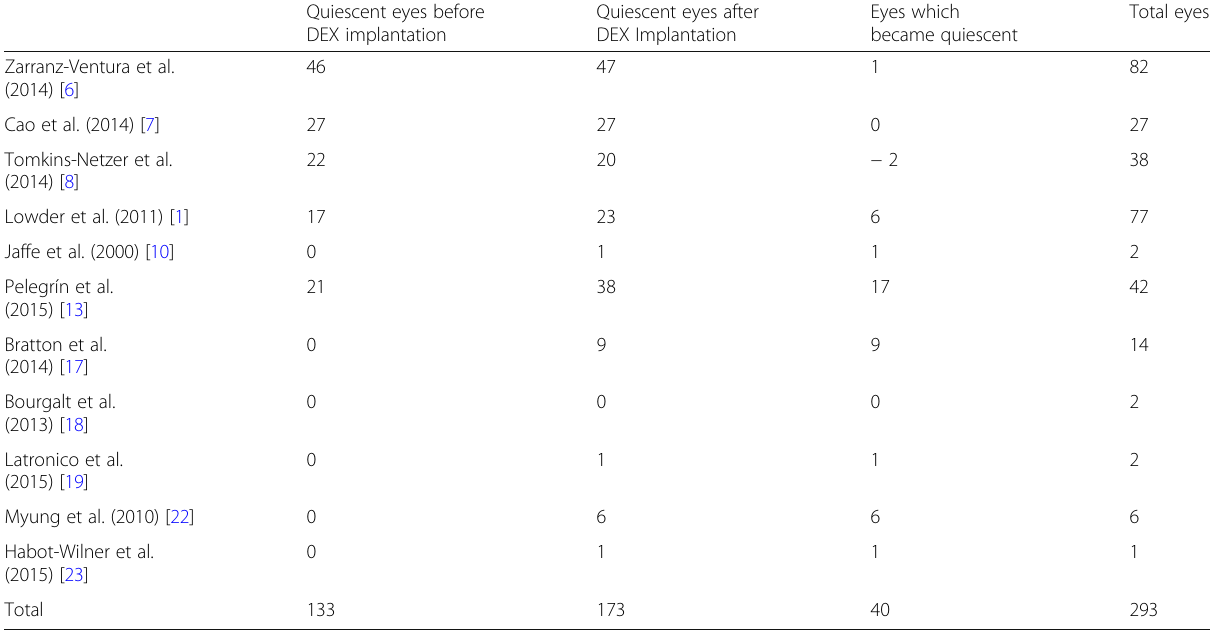
Table 1 The numbers of quiescent eyes before and after the DEX implant